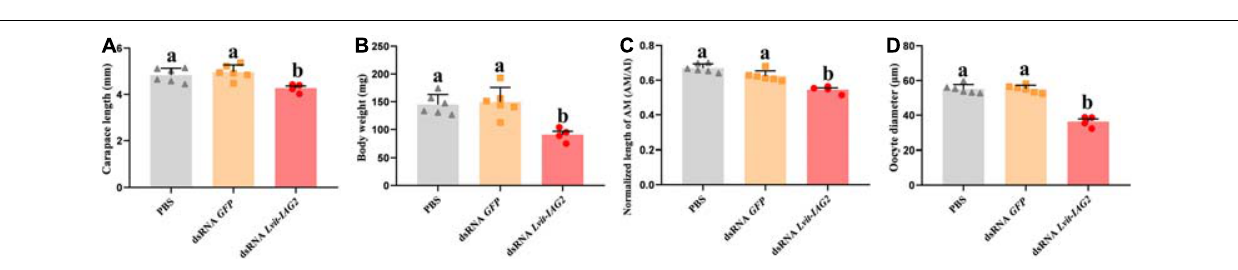
FIGURE 6 | Effects of Lvit-IAG2 silencing on carapace length, body weight, AM length and oocyte diameter of L. vittata . (A) Carapace length; (B) body weight; (C) the normalized length of AM (AM/AI); (D) the oocyte diameter. Data were represented as mean ± SEM (“a and b,” p < 0.05; one-way ANOVA followed by Tukey’s multiple range tests; n =